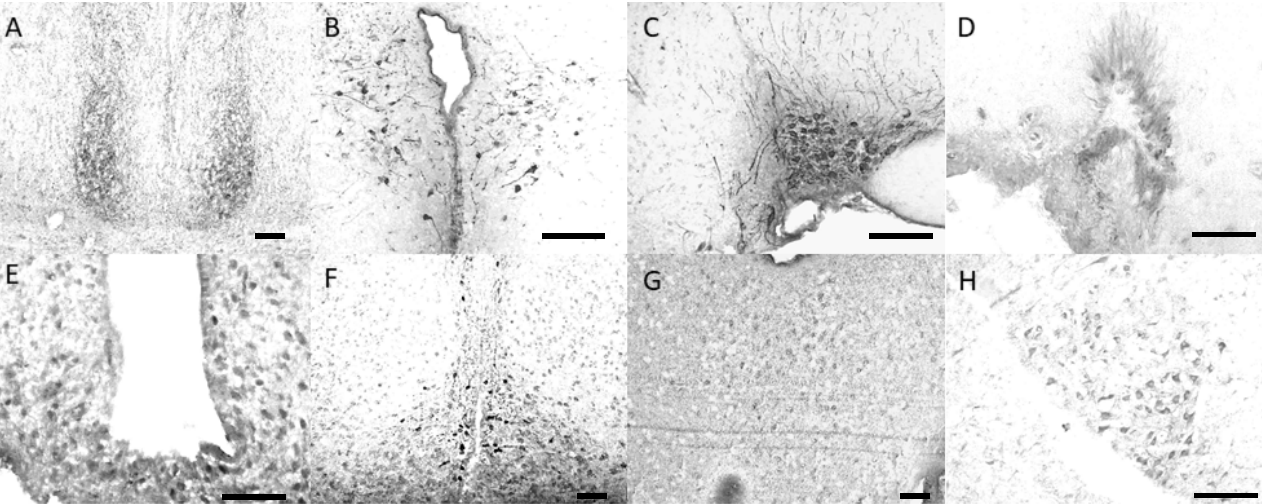
Figure 1. Example microphotographs of cerebral entities of male Syrian hamsters analyzed in the present investigation. ( A ) suprachiasmatic nucleus (anti-gastrin releasing peptide staining), ( B ) paraventricular nucleus (anti-arginine-vasopressin staining), ( C ) supraoptic nucleus (anti-arginine vasopressin staining), ( D ) medial preoptic area (anti-androgen receptor staining), ( E ) medial periventricular nucleus (anti-somatostatin staining), ( F ) infundibular nucleus (anti-tyrosine hydroxylase staining), ( G ) dorsal raphe nucleus (anti-serotonin staining), ( H ) A7 neuron population (anti-dopamine beta-hydroxylase staining). Scale bar 100 µm.